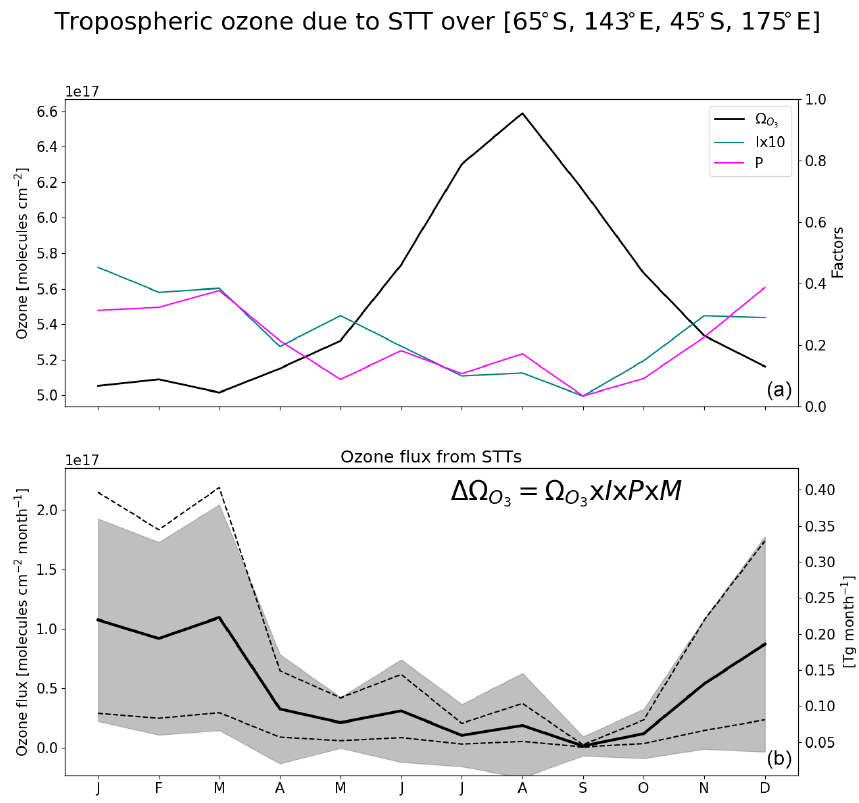
Figure 14. As described in Fig. 13, for the region containing Macquarie